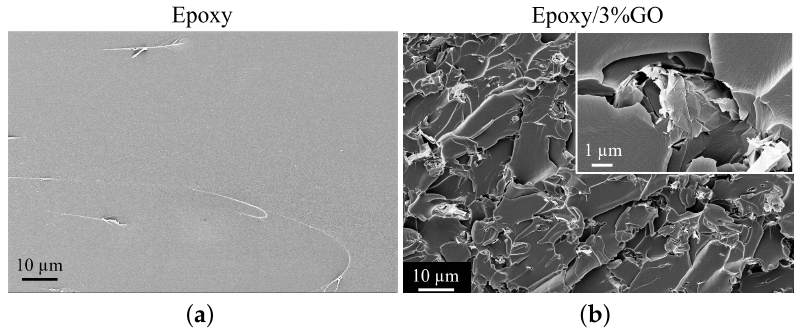
Figure 4. FESEM images of the fractured cross-sections of the ( a ) Epoxy and ( b ) Epoxy/3 wt%GO systems.